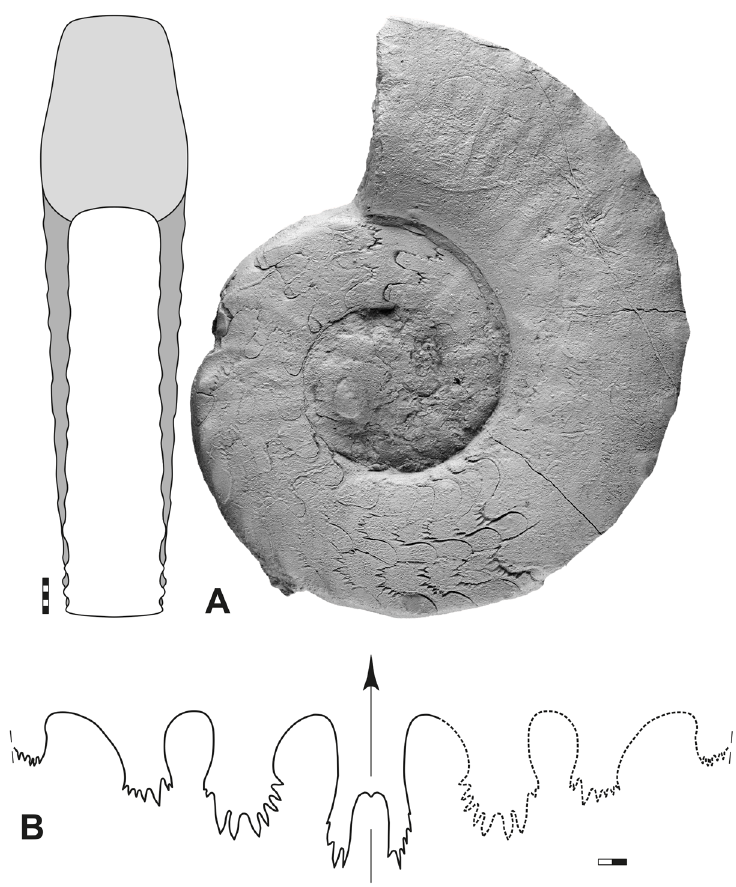
Fig. 55. Lutites plicatus Korn & Hairapetian gen. et sp. nov. A . Lateral and dorsal view, holotype MB.C.30018, section E, float. B . Suture line, holotype MB.C.30018, 13.7 mm ww, 18.6 mm wh. Abbreviations: see Material and methods. Scale bar units = 1